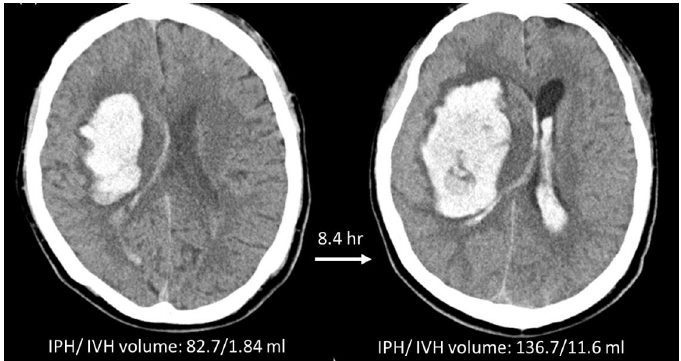
Figure 3. The ROC curves of RM P built using IPH, and RM P+V built using IPH + IVH. The AUC is 0.73 (95% CI: 0.64, 0.80) for RM P , and 0.80 (95% CI: 0.72, 0.87) for RM P+V .